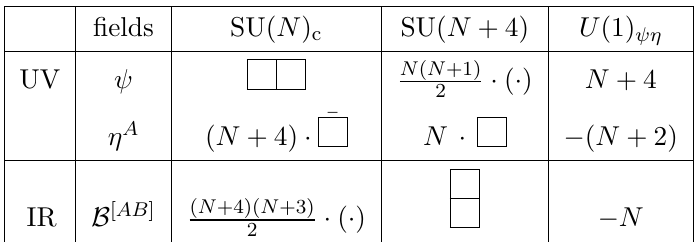
Table 1 . Chirally symmetric phase of the (1 ; 0) model. The multiplicity, charges and the repre- sentation are shown for each set of fermions. ( (cid:1) ) stands for a singlet representation.